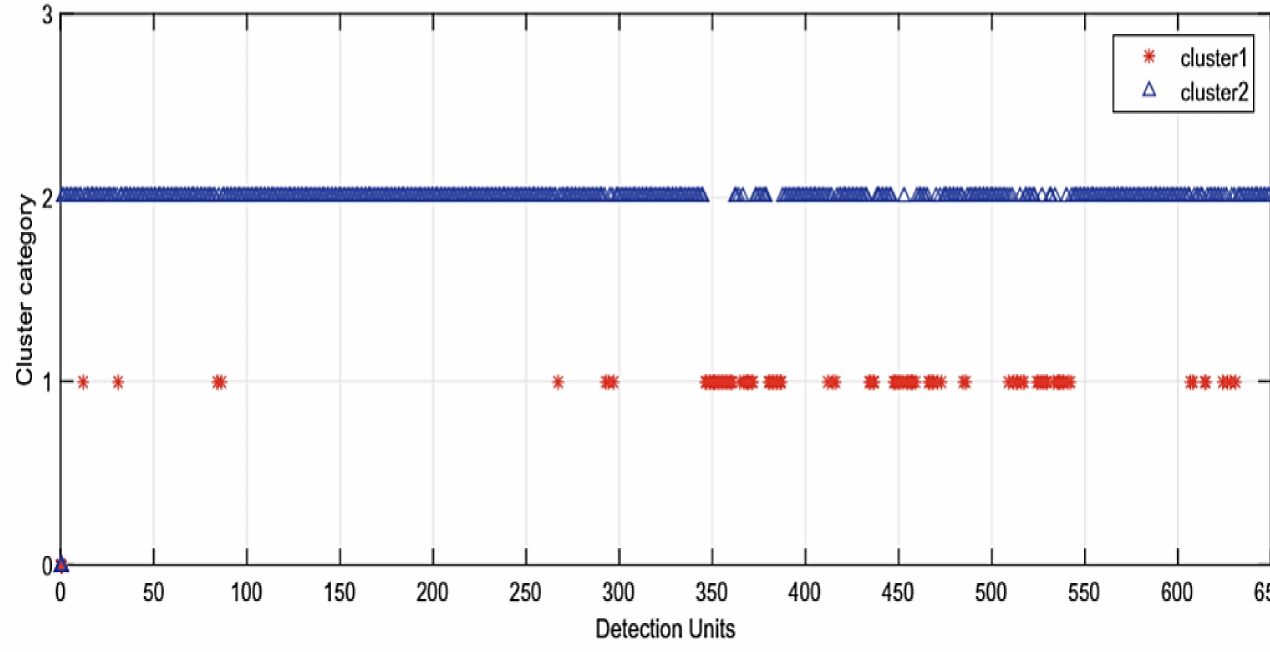
Figure 6. Cluster results of LBNL